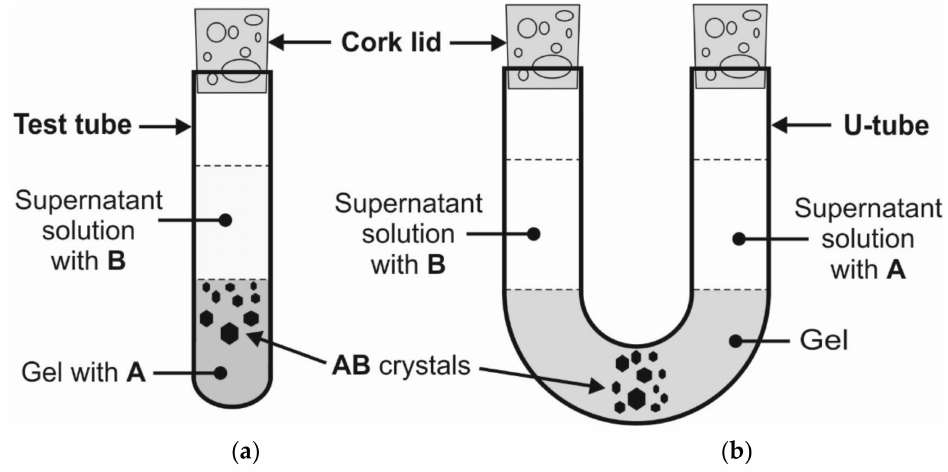
Figure 3. Basic setups of a gel growth experiment: ( a ) Single-diffusion setup; ( b ) Double-diffusion (counter-diffusion)